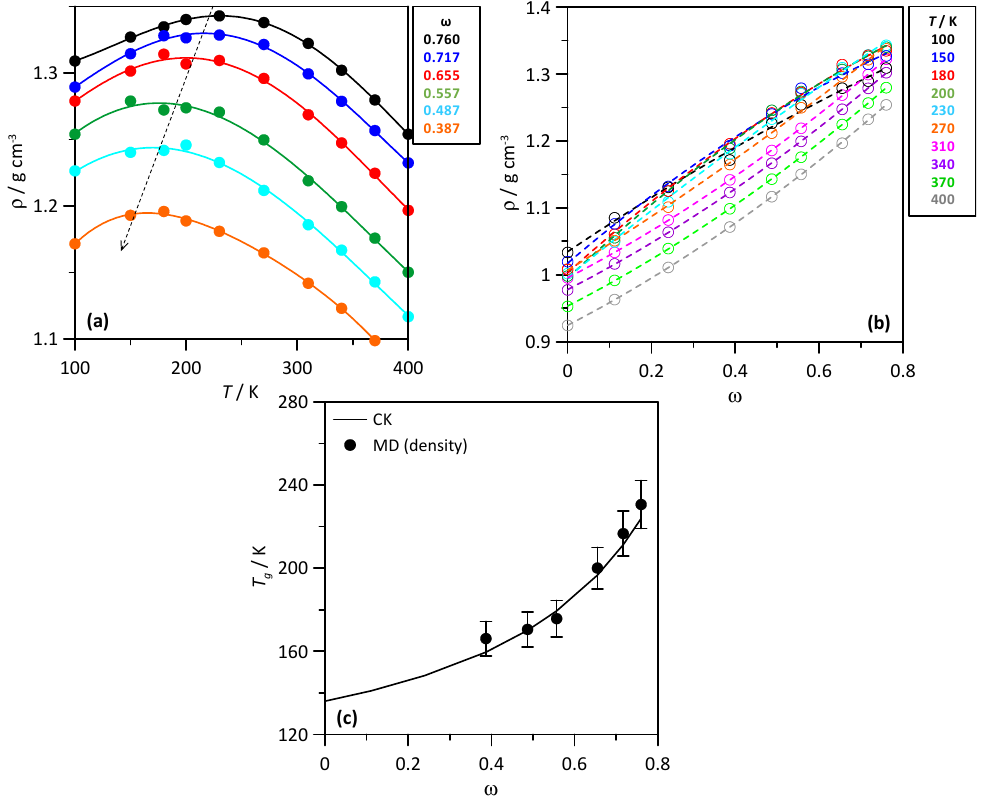
Figure 4. ( a , b ) Density, ρ , and ( c ) glass transition temperature, T g , for ω THAL + (1- ω ) water mixtures. T stands for temperature and ω for THAL mass fraction. Values in panel c were obtained from the maxima of density vs. T curves (MD) and compared with those predicted from CK model. In panel a, dashed arrow indicates the shifting of curves maxima with decreasing THAL